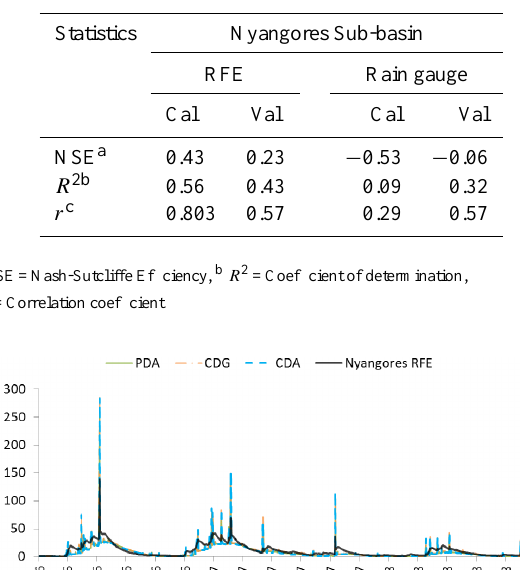
Table 7. Model evaluation statistics for monthly discharge simula- tion result.